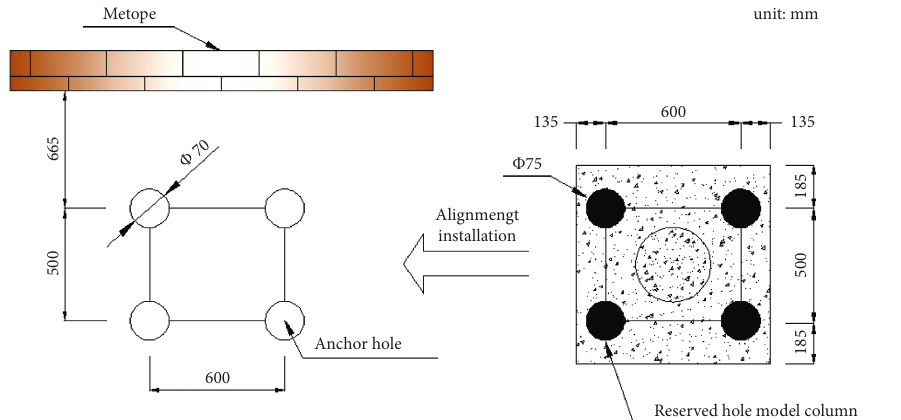
Figure 7: Installation of the model